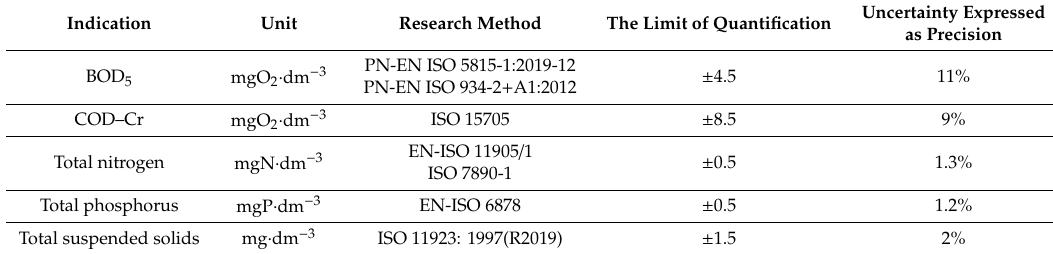
Table 3. Physicochemical analyses of selected water quality parameters—list of methods